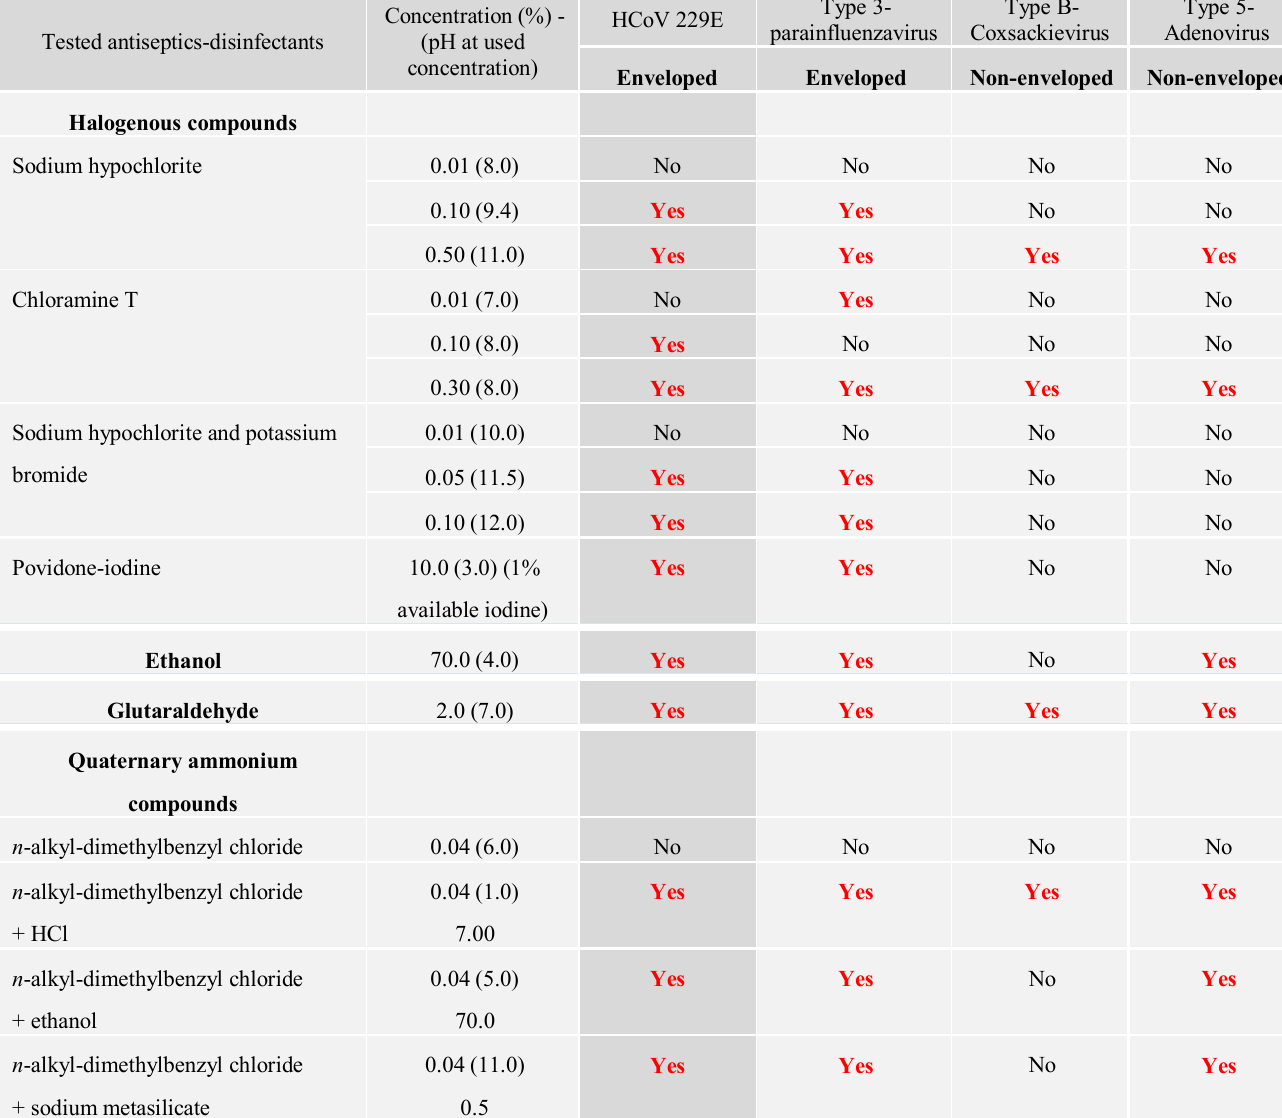
Table 2. Comparison of non-enveloped and enveloped viruses (HCoV 229E, type 3- parainfluenzavirus, type b-coxsackievirus and type 5-adenovirus) sensitivity to different antiseptics-disinfectants formulations, thanks to carrier tests